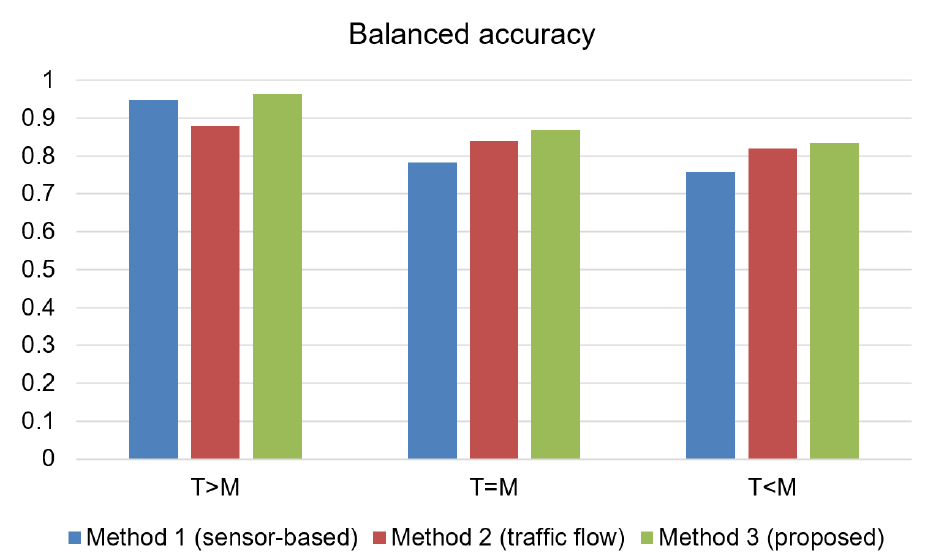
Figure 11. Accuracy of malicious data detection methods for different share of malicious vehicles.